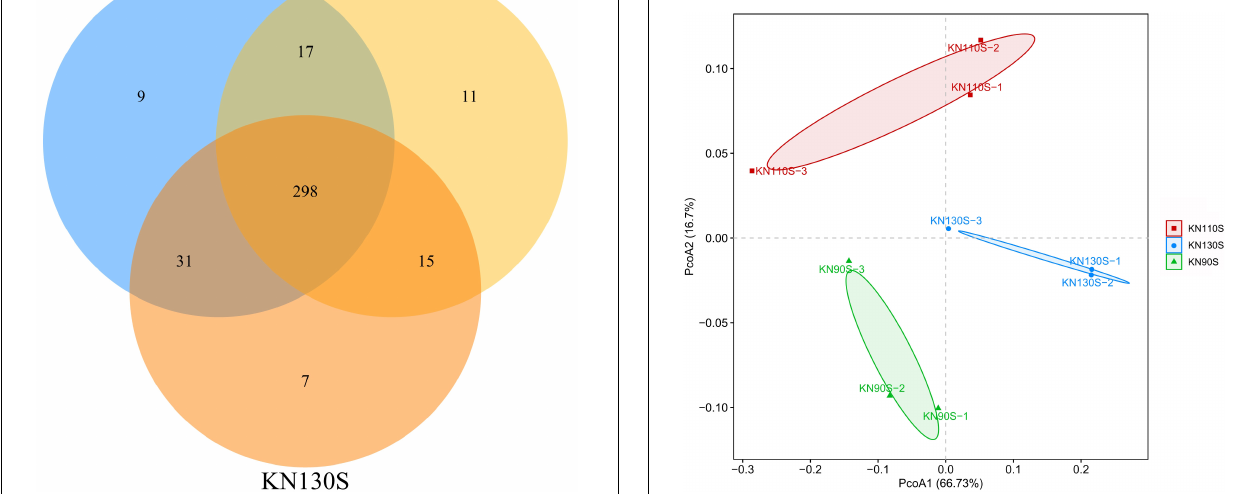
Frontiers in Microbiology |